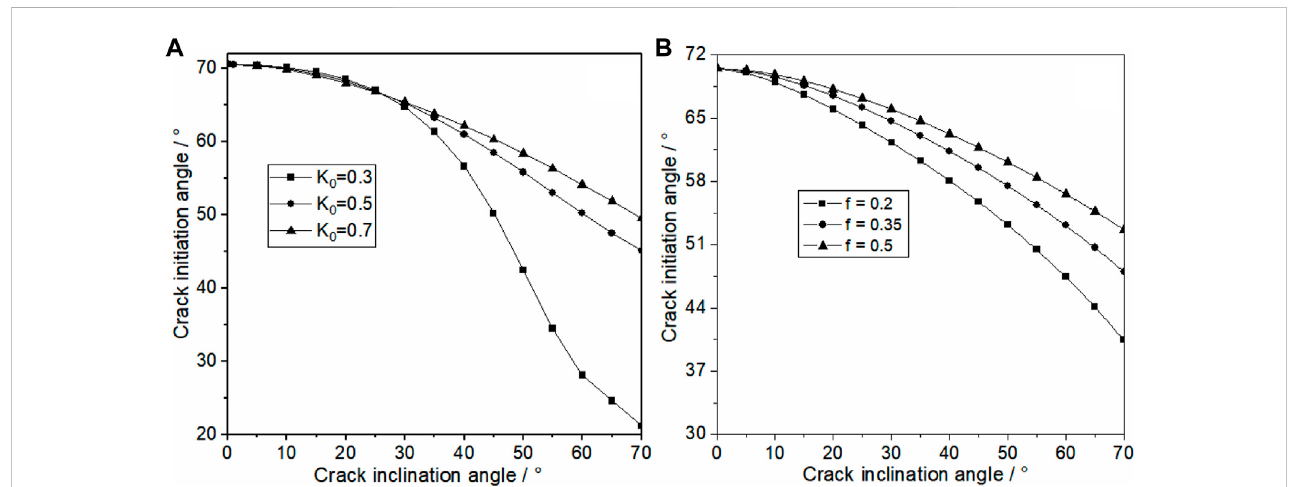
FIGURE 5 Variation in the crack initiation angle with the crack dip angle: (A) in fl uence side of the side-pressure coef fi cient and (B) in fl uence of the side-friction coef fi cient.